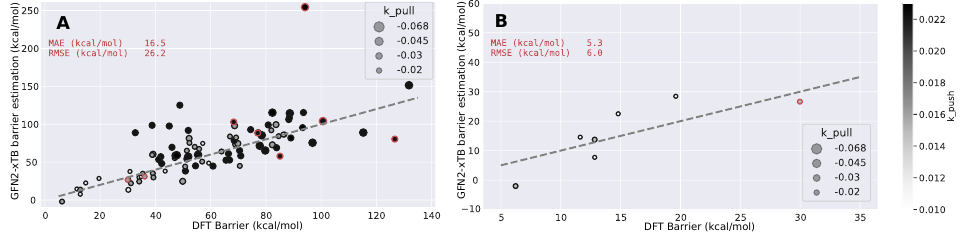
Figure 6 Barrier estimates from GFN2-xTB compared to DFT (UB3LYP/6-31G**) barriers for the first run shown in Fig. 2. k pull and k push values are given in Hartree per atom. For each point is indicated the pull strength (color) and the push strength (size). Reactions where the search was unsuccessful are labelled with red edges. (A) of the figure shows estimates for all (91) reactions while (B) shows barrier estimates for reactions with a barrier of less than 30 kcal/mol.